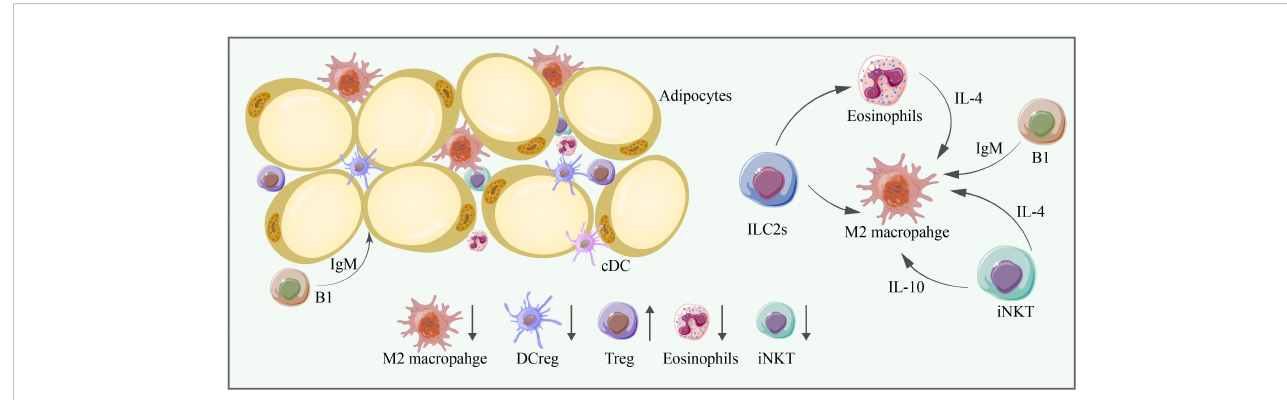
FIGURE 4 M2 macrophages, DCregs, Tregs, eosinophils, and iNKT cells are signi fi cant anti-in fl ammatory immune cells in adipose tissue, and their abundance is mostly decreased in aging adipose tissue. Cell – cell interactions are essential for adipose tissue homeostasis. ILC2s can promote the proliferation of eosinophils and M2 macrophages, and eosinophils can promote the proliferation of M2 macrophages through IL-4. iNKT cells can promote the proliferation of M2 macrophages through IL-4 and IL-10. B1 cells produce IgM, which exerts anti-in fl ammatory effects and promotes the proliferation of M2